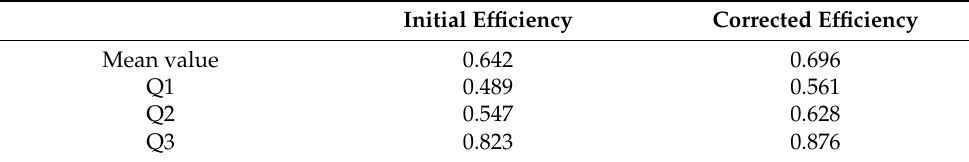
Figure 4. ( a ) Revised results of carbon emission efficiency in Northeastern China, 2006–2019; ( b ) revised results of carbon emission efficiency in Eastern China, 2006–2019; ( c ) revised results of carbon emission efficiency in Central China, 2006–2019; ( d ) revised results of carbon emission efficiency in Western China, 2006–2019. Note: To ensure the effect of the figure, the results of 2008, 2011, 2014, and 2017 are not shown; please contact the author to obtain them if necessary. Table 4. Comparison of the overall distribution of initial and modified